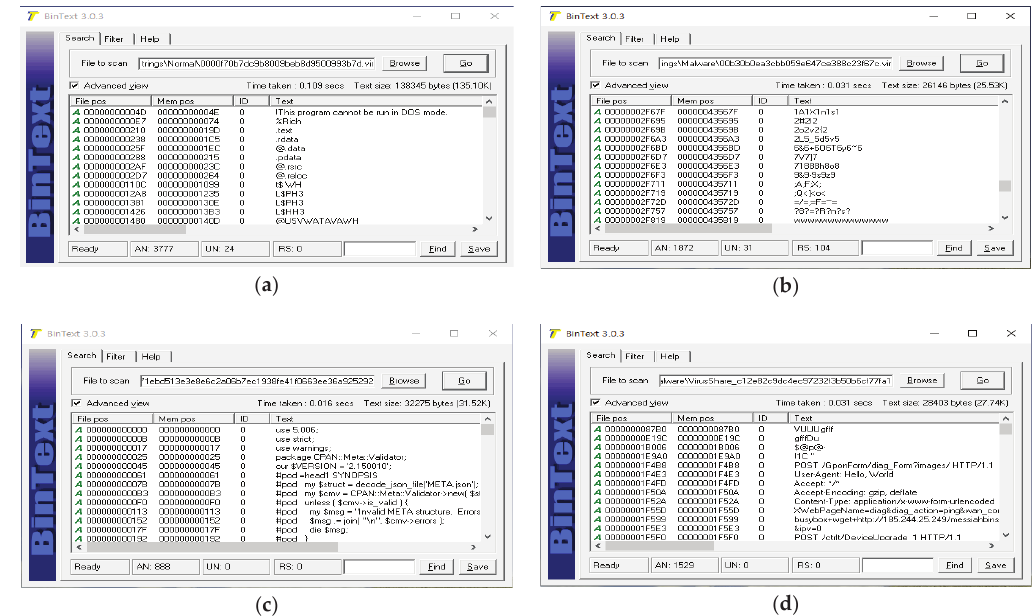
Figure 8. String analysis example in binary data: ( a ) Windows benign file analysis; ( b ) Windows